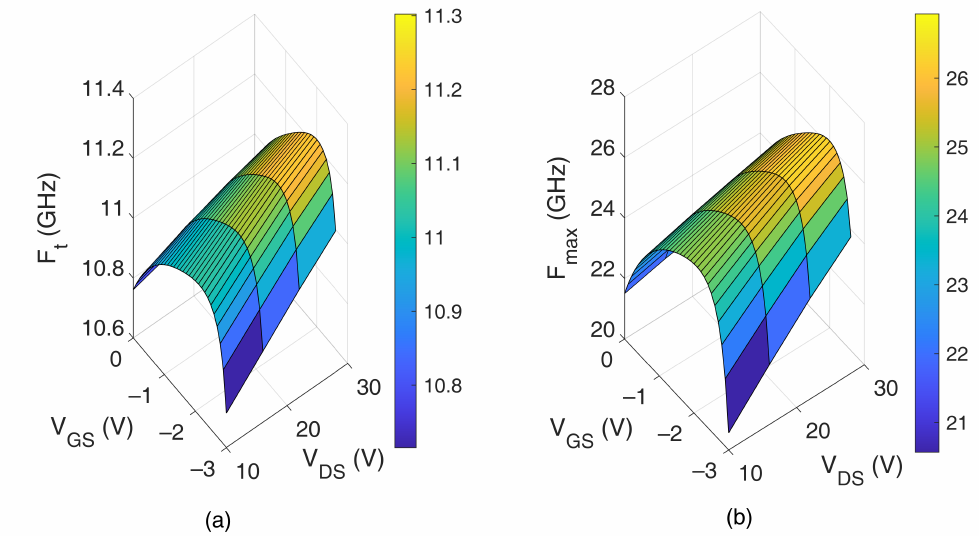
Figure 3. Cut − off ( a ) and maximum ( b ) frequency of the CGH40010F versus V GS and V DS .